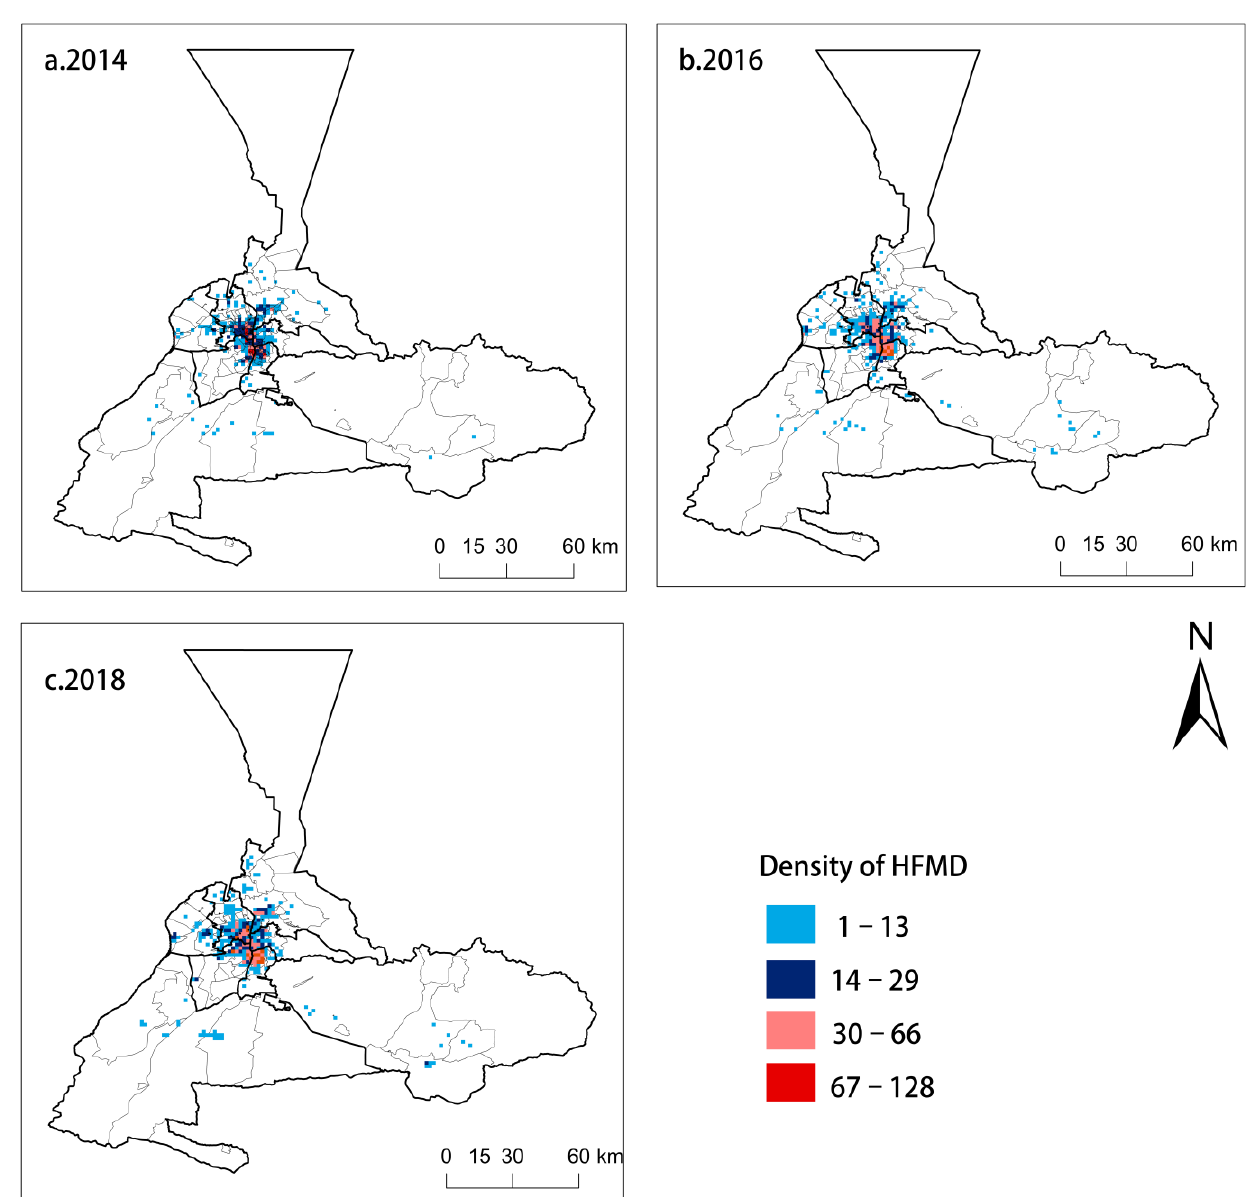
Figure 2. Spatial distribution of HFMD (Hand, foot, and mouth disease) in Urumqi from 2014 to 2018 — ( a ). 2014, ( b ). 2016, ( c ). 2018.